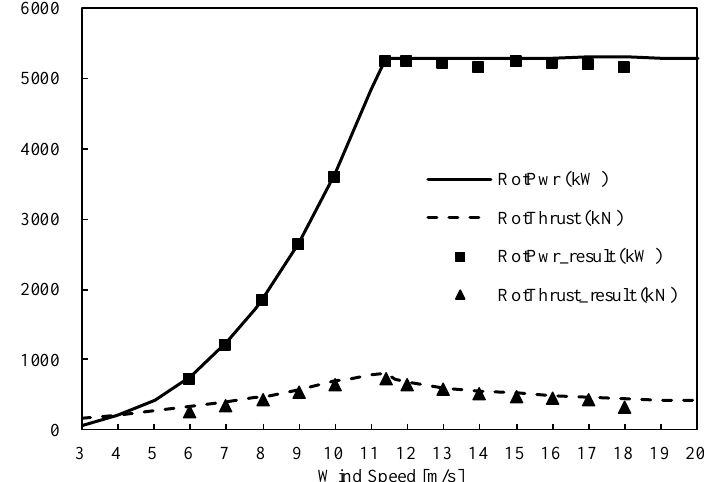
Figure 2. Power and thrust outputs of the NREL 5-MW wind turbine as a function of wind speed.